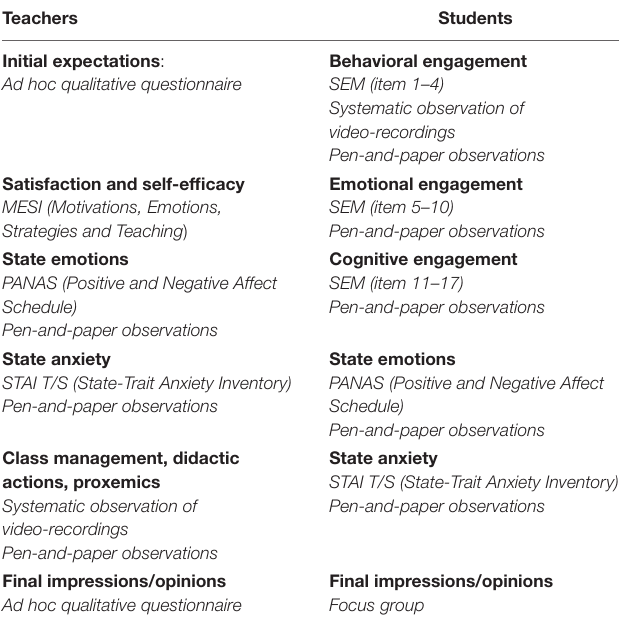
TABLE 1 | Observed dependent variables and adopted